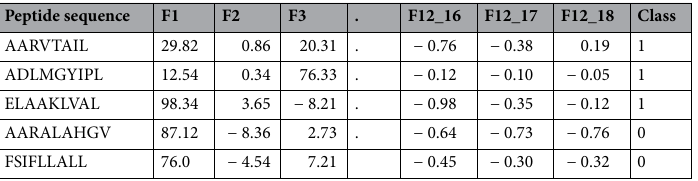
Table 2. Snapshot of the